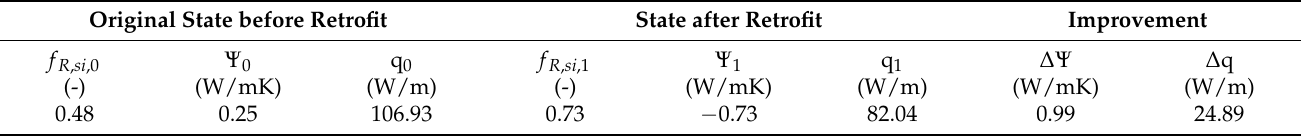
Table A23. Quantifiable results of the thermal bridge retrofit of an attic (ThermCad thermal bridge simulation calculation). Original State before